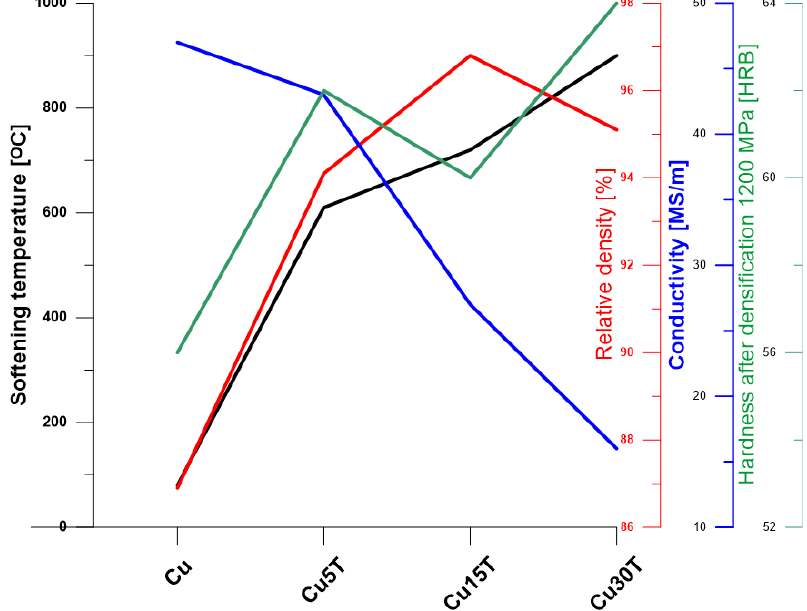
Figure 9. Effect of tuff content on the properties of copper matrix composites: softening temperature (black), relative density (red), electrical conductivity (blue), and hardness (green). Samples were compressed in the mold at 1200 MPa pressure.